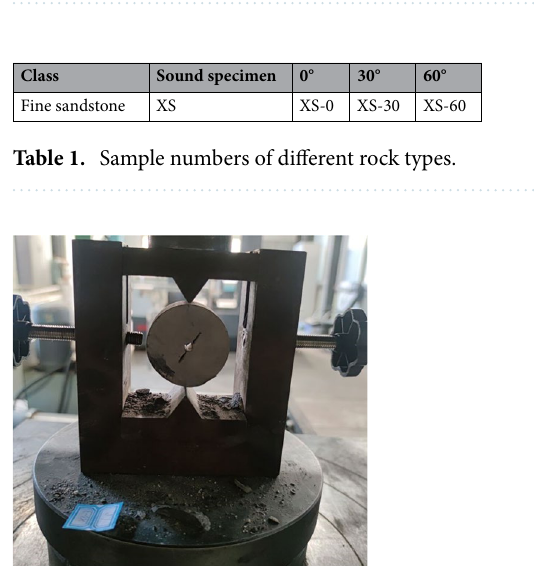
Figure 1. Partial model diagram and loading diagram.